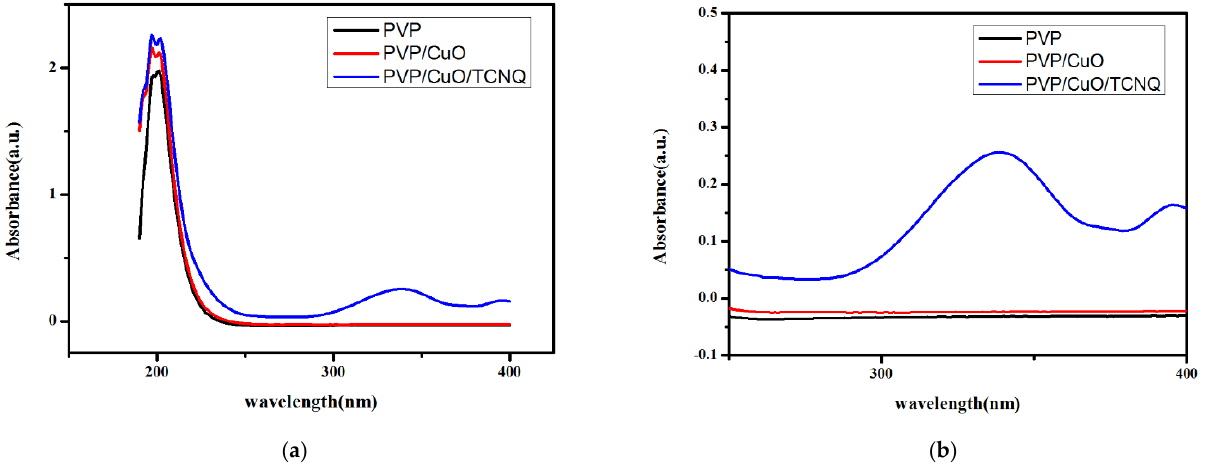
Figure 6. ( a ) UV – Vis spectrum of PVP, PVP/CuO, and PVP/CuO/TCNQ composites, and ( b ) enlarged image of ( a ).